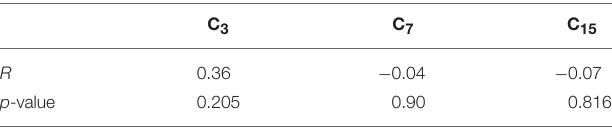
TABLE 2 | Correlations obtained by using instantaneous values C t of model